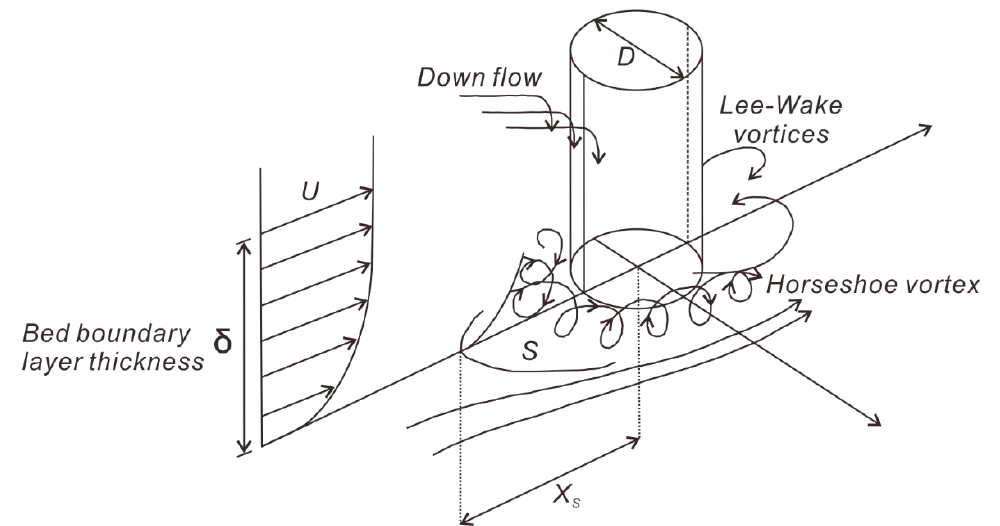
Figure 10. Definition sketch of a horseshoe vortex (reproduced from [16]).